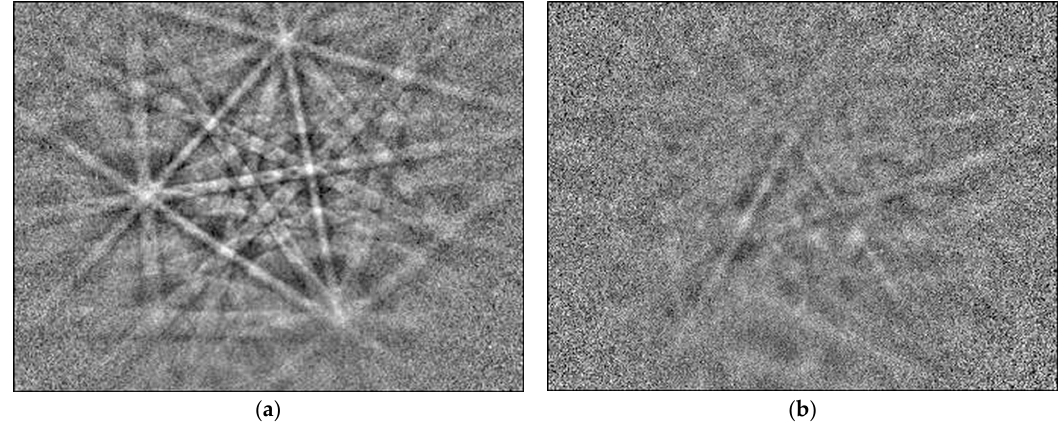
Figure 2. EBSD patterns obtained on: ( a ) sputtered area (crater depth) and ( b ) non-sputtered area (mechanically polished area) of steel 1.4509 (AISI 441).